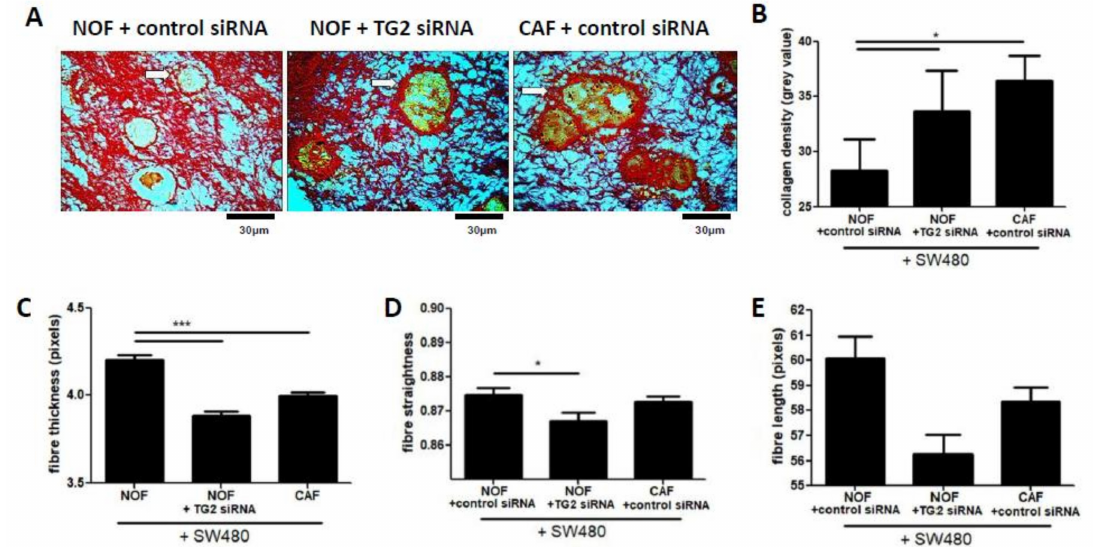
Figure 4. TG2 mediates structural features of collagen fibroblast / CRC co-cultures. Sirius red staining of fibroblast / SW480 co-cultures showed distinctive patterns of dense collagen accumulation at the CRC / stroma boundary ( A , white arrows). Quantification of the collagen density at this boundary indicated that treating NOFs with TG2 siRNA caused a significant increase of collagen density in these areas ( B , n = 10–17). However, treating NOFs with TG2 siRNA lead to overall lower collagen fibre thickness in the gels ( C , n = 10–17) and fibres that were significantly less straight ( D , n = 10–17). No di ff erence in fibre length was observed between the conditions ( E , n = 10–17), despite a trend towards shorter fibre length in gels cast with NOFs treated with TG2 siRNA ( E ). * p < 0.05, *** p <